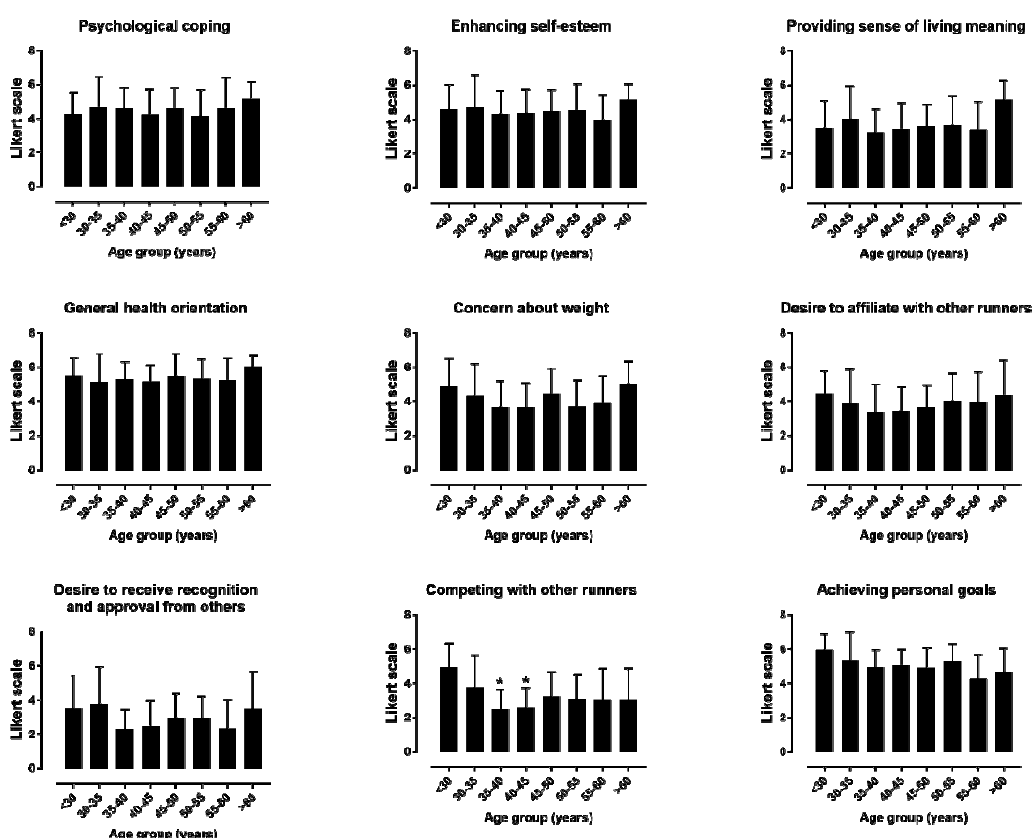
Figure 3. Nine MOMS specific themes by age group in male participants. * p < 0.05. It should be noted that the Likert scale ranges from 1 to 7.